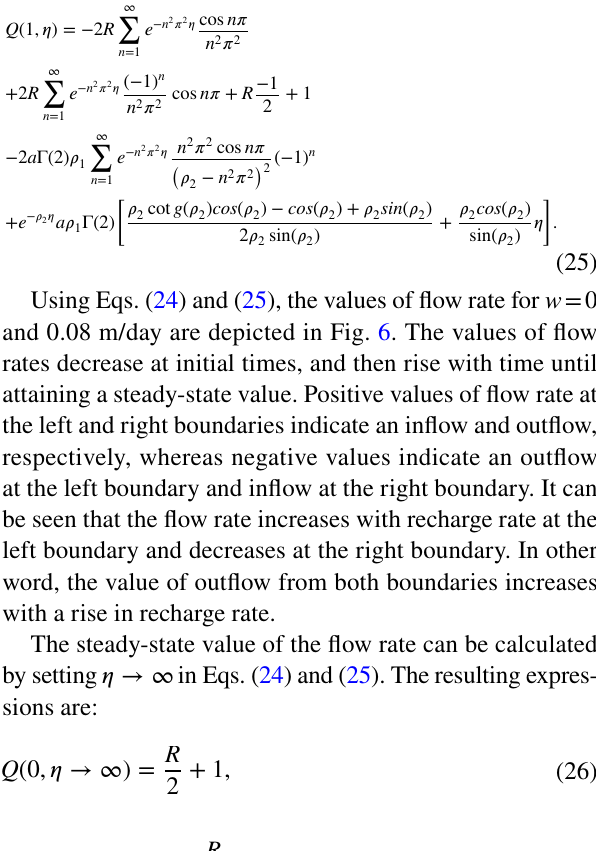
Fig. 4 Comparison of the exact model with MODFLOW